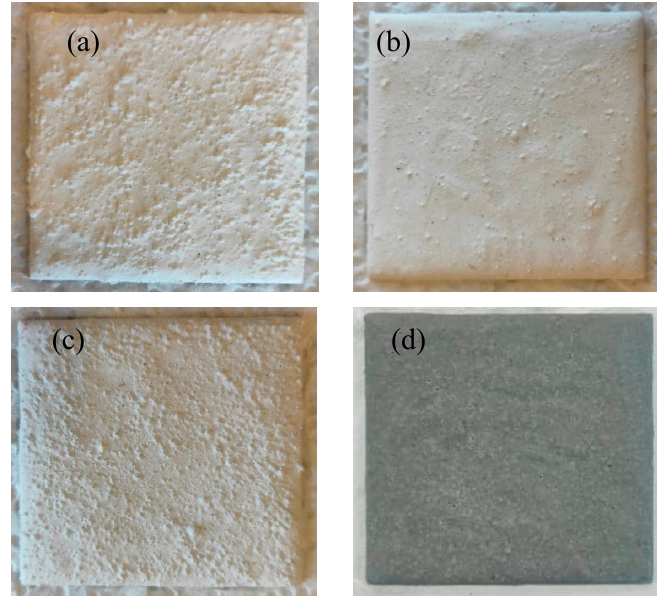
Figure 11. After 70 cyclic tests: ( a ) BAIC 1-0, ( b ) BAIC 3-5, ( c ) BAIC 5-0 and ( d ) BAIC 10-0.